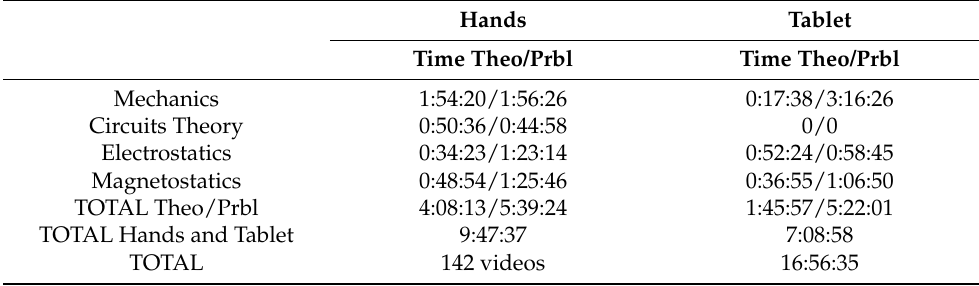
Table 1. Number of videos created with tablet and with hands. The number of videos of theory and problems is specified for each group